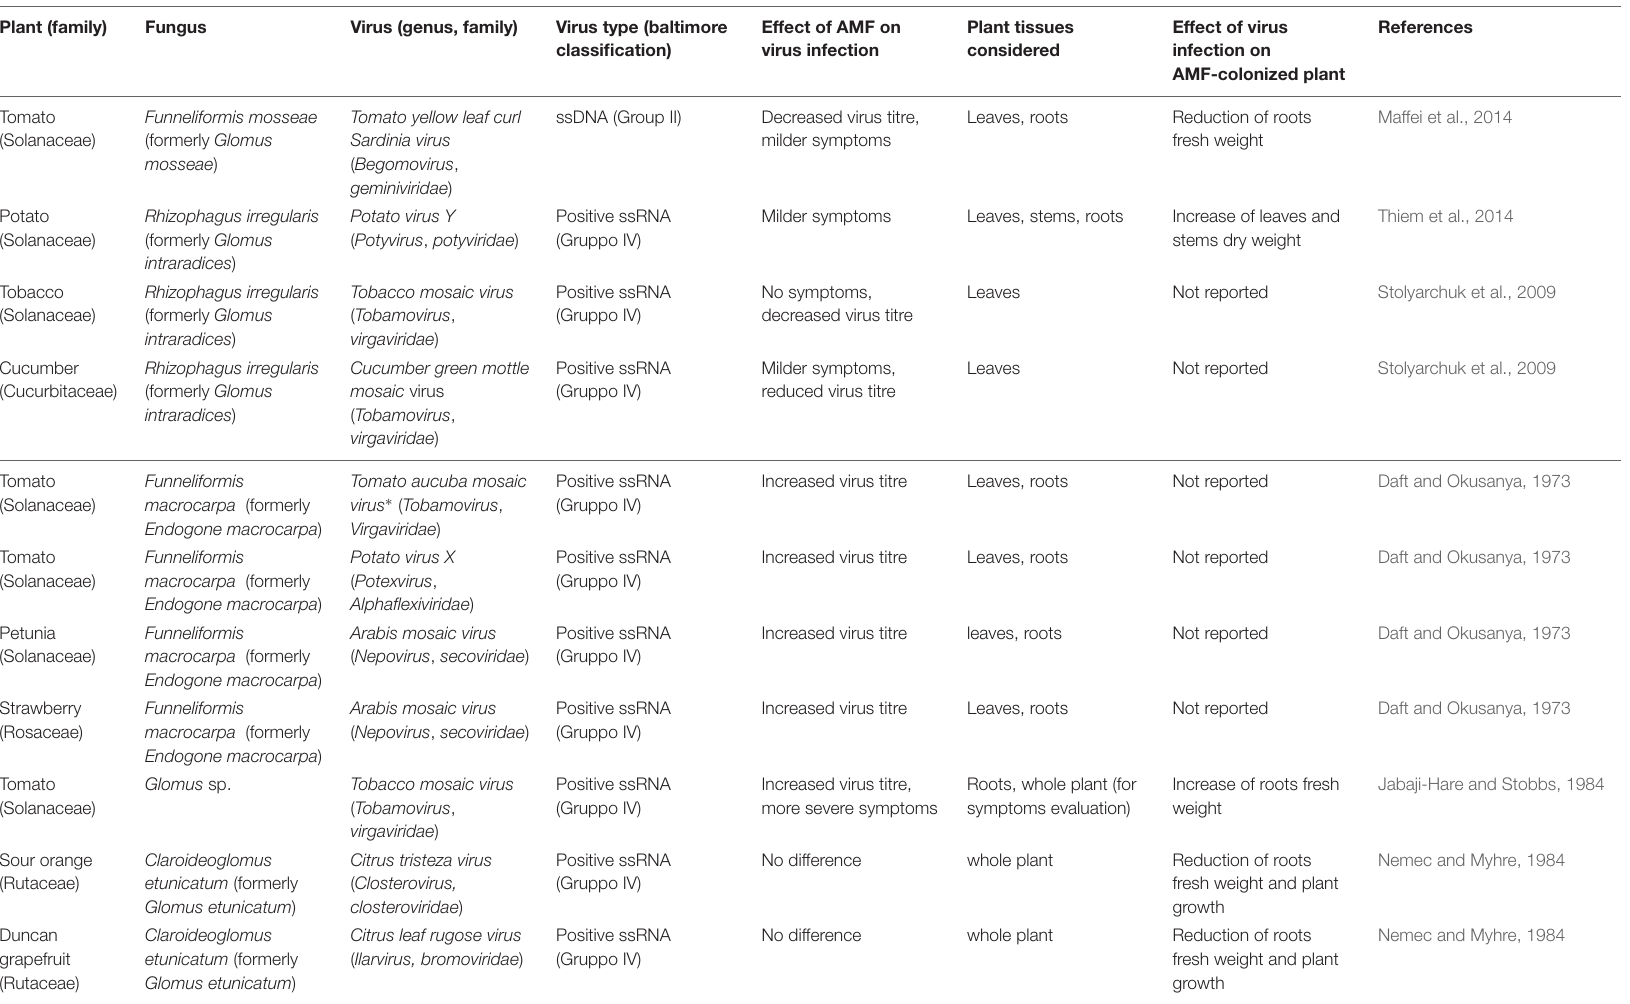
TABLE 1 | AMF-plant-virus biological systems investigated; in the upper section are listed the case studies reporting a protective effect of AMF against viral infection while in the lower section are listed those reporting a detrimental effect. Plant